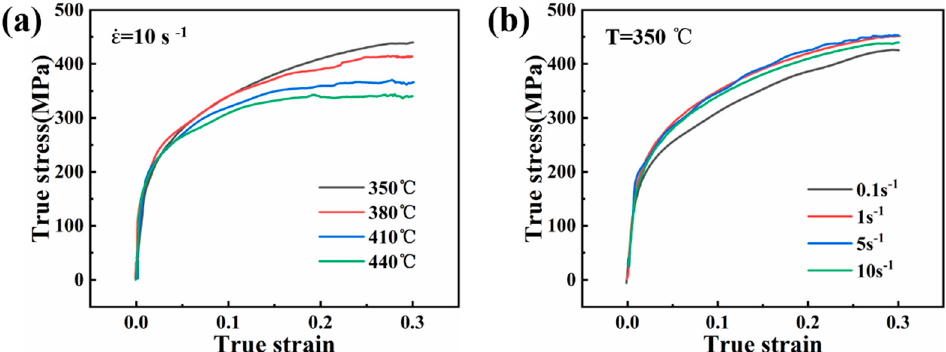
Figure 4. True stress–true strain curve for semi-solid CuSn10P1 alloy: ( a ) at strain rate of 10 s − 1 and temperatures of 350 − 440 °C, ( b ) at temperature of 350 °C and strain rates of 0.1 − 10 s − 1